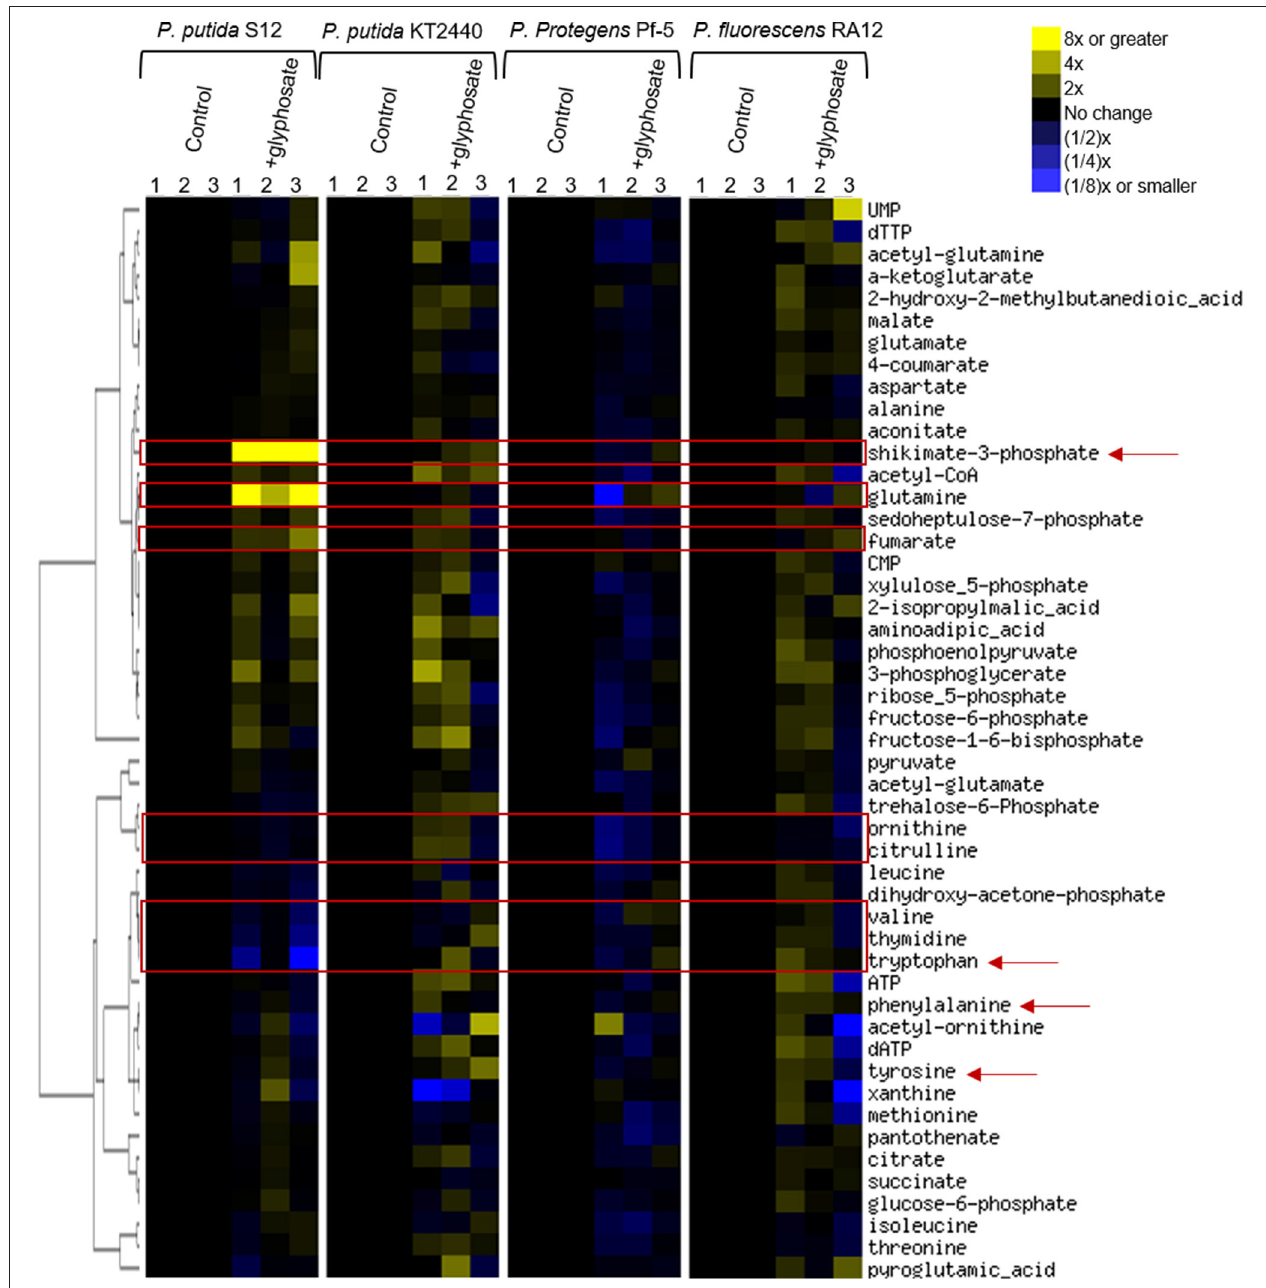
FIGURE 3 | Fingerprinting of the cellular metabolome of P. putida S12, P. putida KT2440, P. protegens Pf-5, P. fluorescens RA12. Unsupervised hierarchical clustering of metabolite levels in succinate-grown cells in the absence (control) and presence of 0.5mM glyphosate ( + glyphosate). Columns 1, 2, and 3 represent data from independent biological replicates. The red rectangular boxes highlight metabolite levels in the metabolome that were disrupted in the presence of glyphosate. The red arrows indicate metabolites that are present in the shikimate